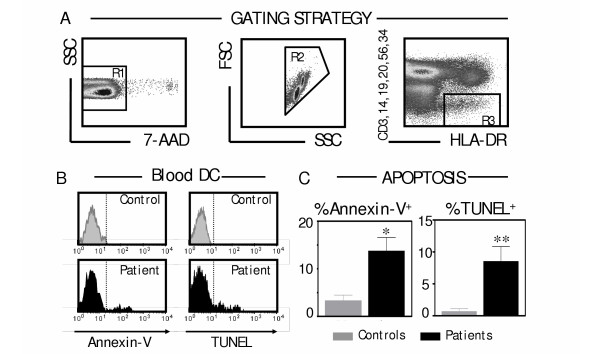
Spontaneous apoptosis of blood dendritic cells (DCs) in patients with breast cancer. Peripheral blood mononuclear cells isolated from patients with breast cancer (stage I to II; n = 13) and age-matched healthy volunteers (n = 15) were analyzed for apoptosis by flow cytometry. (a)In order to include all apoptotic cells and avoid debris, gating was set to include only 7-AAD negative events (R1) which were then visualized and re-gated on forward (FSC) and side scatter (SSC) characteristics (R2). Within this mononuclear cell population, blood DCs were identified as lineage negative HLA-DR positive cells (R3). Representative dot plots are shown. (b)Apoptosis in blood DCs from patients (black) and healthy volunteers (grey) was determined by two different methods, Annexin-V binding and TUNEL assays. In all experiments, each patient was tested in parallel with at least one healthy volunteer. Representative histograms are shown. (c)Summary of apoptosis data. The proportions of Annexin-V+ and TUNEL+ blood DCs estimated for all patients (black) and healthy volunteers (grey) are shown accordingly. Error bars indicate the standard error of the mean. Statistically significant differences between controls and patients are indicated as: *, p < 0.05; **, p < 0.01.